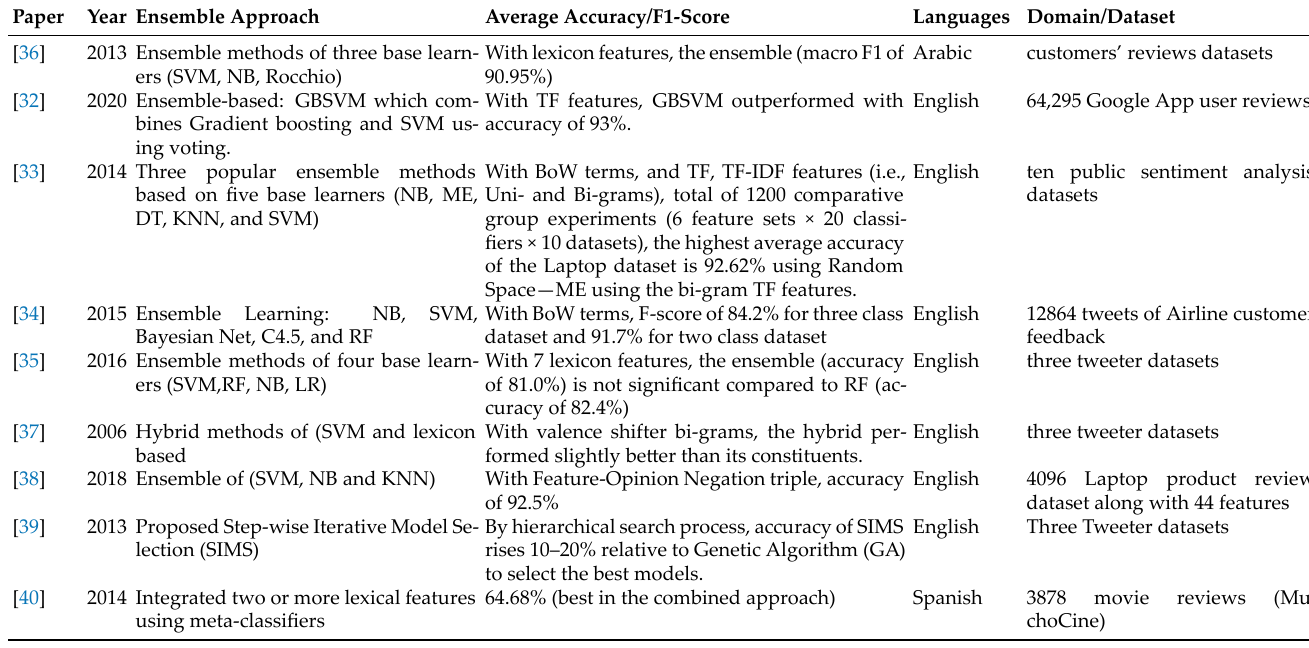
Table 1. Summary of key related work of ensemble‑based sentiment